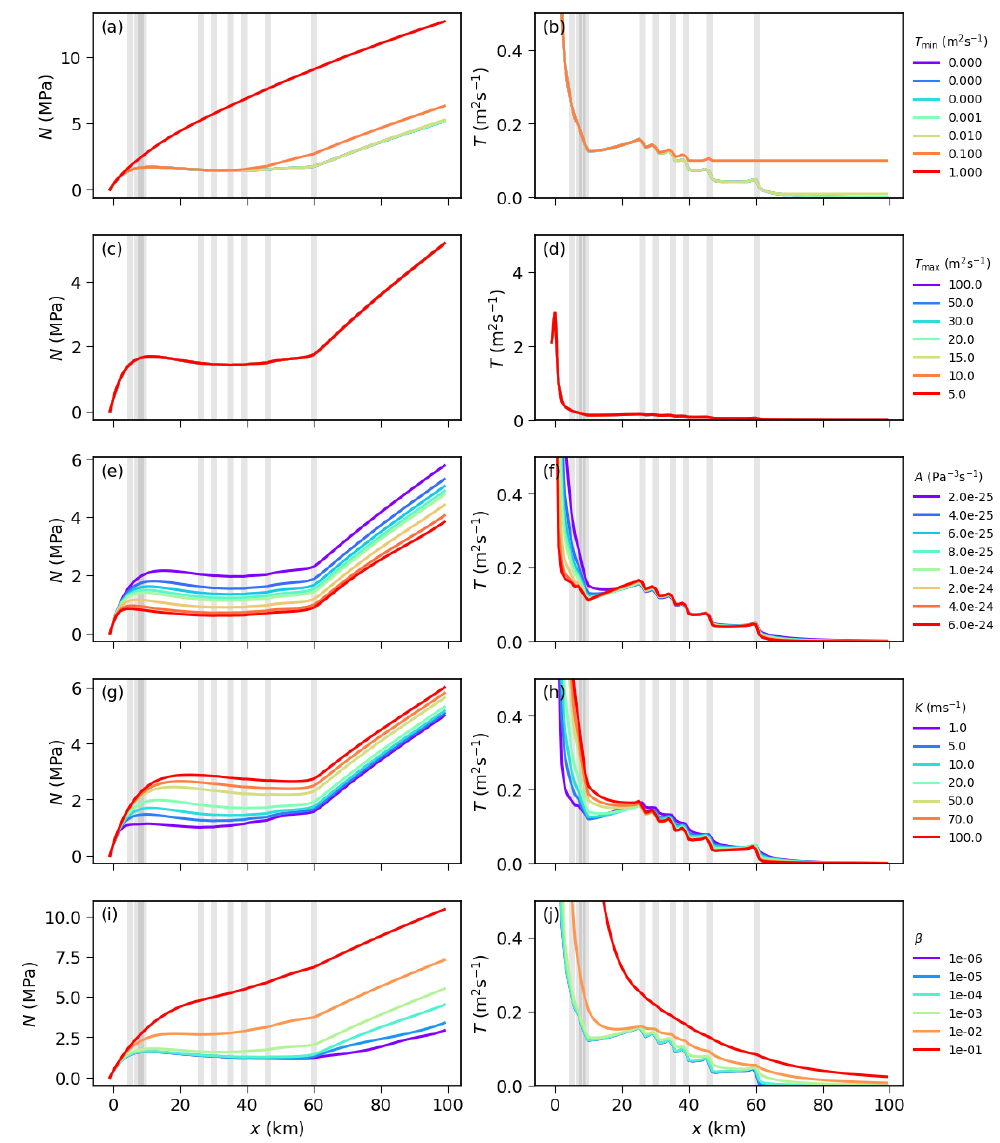
Figure 4. Results from parameters directly related to opening and closure: limits on the transmissivity T min (a, b) and T max (c, d) , creep rate factor A (e, f) , conductivity K (g, h) , and cavity opening parameter β (i, j) . Values shown are averaged along the y axis to represent cross-sections at flow lines. Transmissivity plots are cut off at 0.5m 2 s − 1 to improve visibility of the relevant